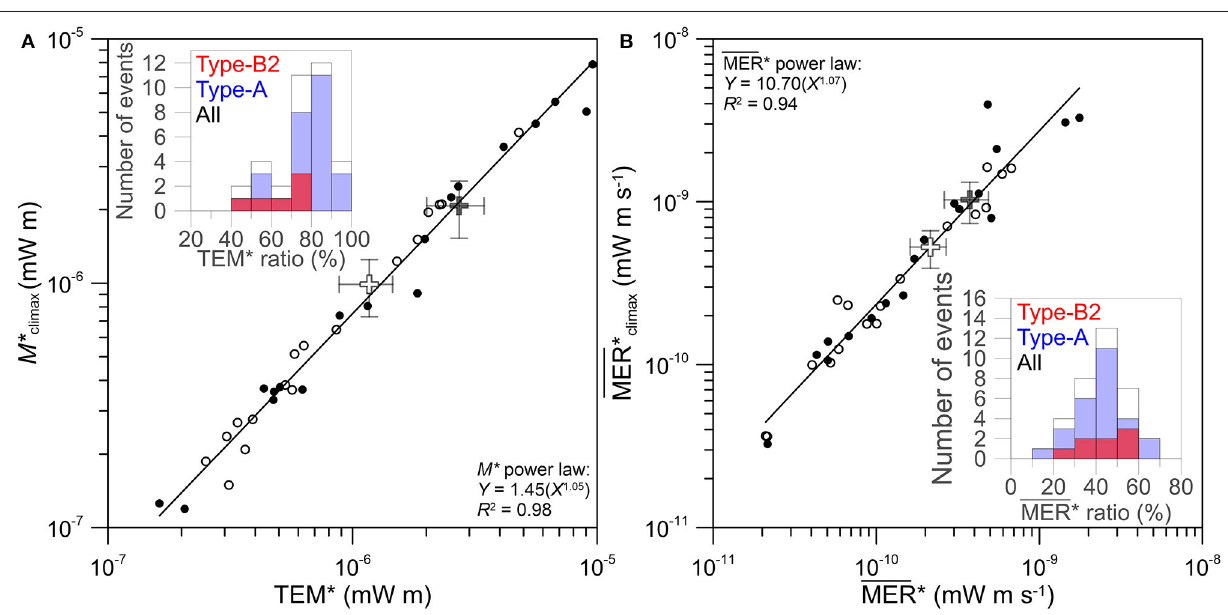
FIGURE 5 | (A) Correlation between the relative masses of tephra emitted during the climax ( M * climax ) and during whole paroxysmal episodes (TEM*), as inferred from radar records of the 2011–2012 (open circles) and 2013–2015 (black circles) paroxysms. The open and black crosses corresponds to the average values for both periods. Error bars corresponds to the standard error of the mean. Inset: Histogram of the tephra mass proportion released during the climax, as deduced from M *. (B) Correlation between Mass Eruption Rate Proxies averaged over climax duration (MER* climax ) and over whole paroxysmal duration (MER * ). Inset: Histograms of the ratio of Mass Eruption Rate (MER*) averaged over the whole paroxysm duration relative to that of the climax. Paroxysms typology is also shown: B2-type (red bars), A-type (blue bars) and all (black